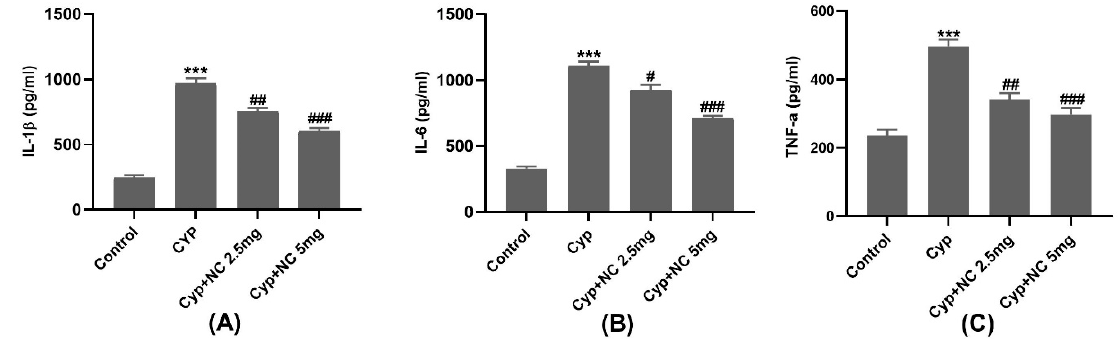
Figure 3. Cur-NLC treatment suppressed IL-1 β ( A ), IL-6 ( B ), and TNF- α ( C ) expression induced by Cyp. Value expressed as mean ± SEM (n = 6). *** p < 0.001 vs. control, # p < 0.05, ## p < 0.01, ### p < 0.001 vs. Cyp group. Cyp = cypermethrin; NC = NLC.